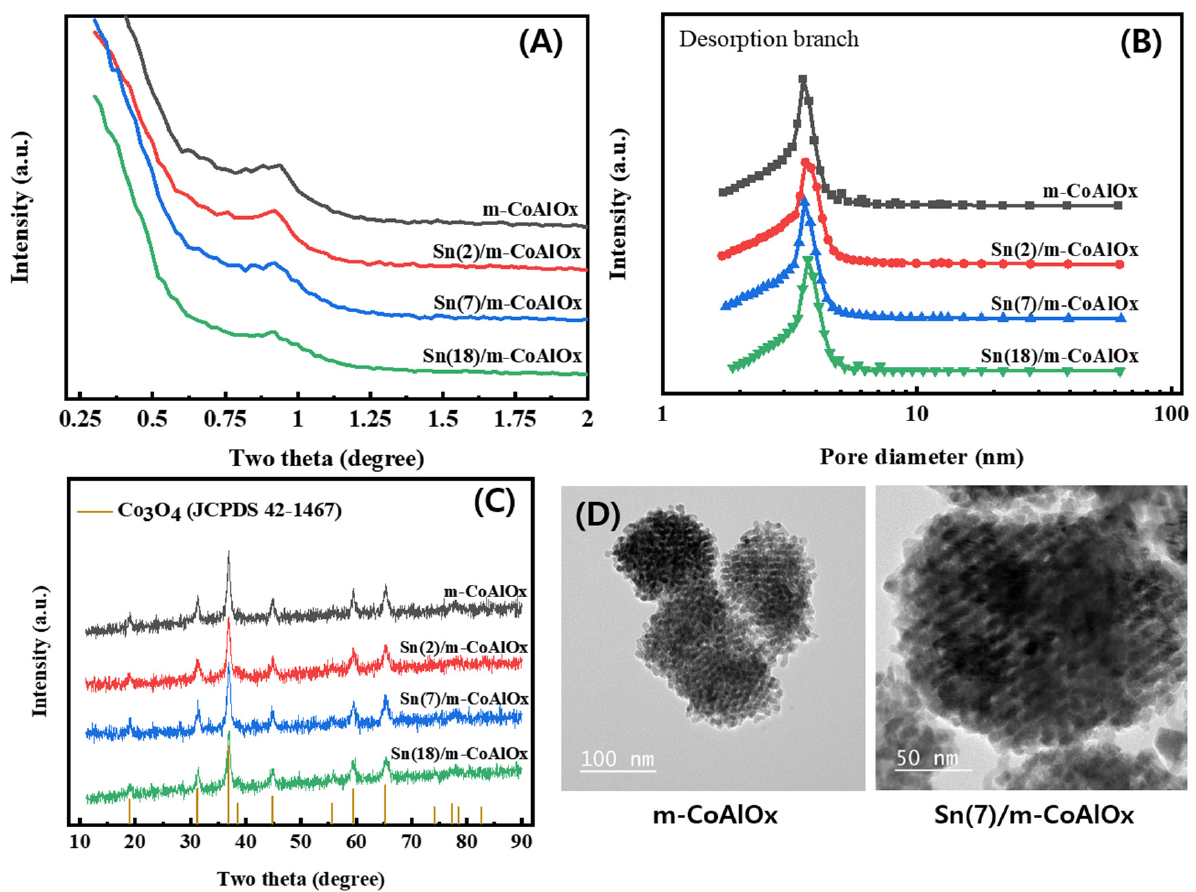
Figure 1. Characteristics of the fresh Sn/m-CoAlOx catalysts; ( A ) Small angle XRD patterns, ( B ) Pore size distribution measured by N 2 sorption, ( C ) Wide angle XRD patterns and ( D ) TEM images of the m-CoAlOx and Sn(7)/m-CoAlOx. Table 1. Bulk and surface properties of the Sn/m-CoAlOx catalysts such as metal composition, sur- face area, particle size and reducibility.